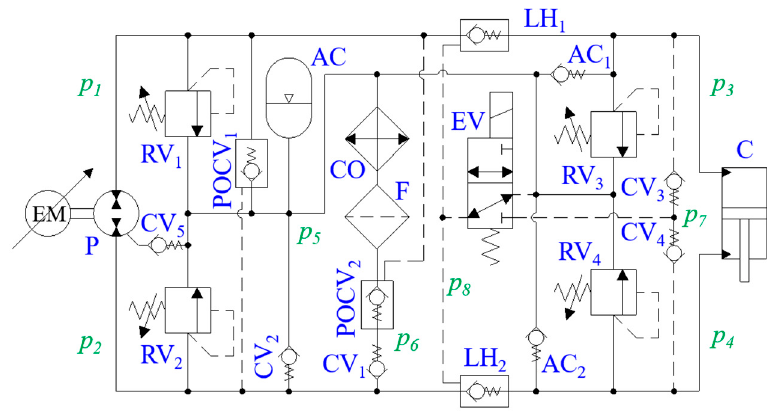
Figure 2. System architecture of the investigated self-contained cylinder.